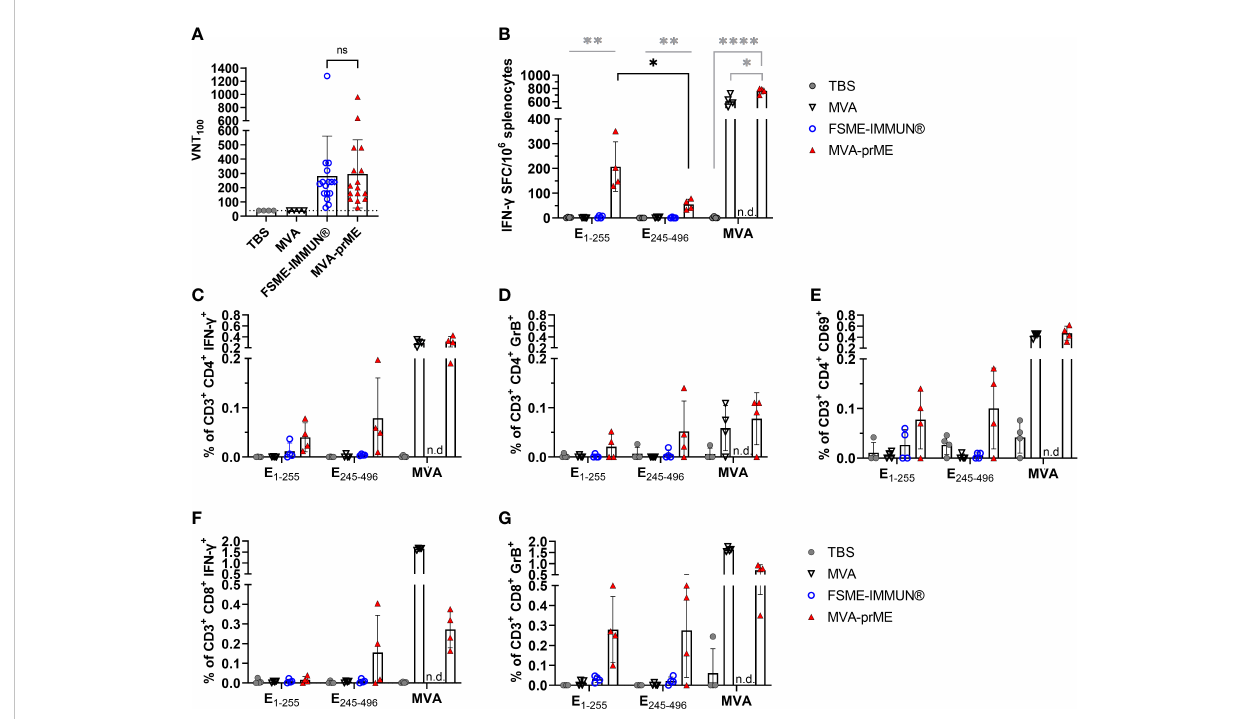
FIGURE 2 Humoral and cellular immune response in vaccinated mice. (A) Virus-neutralizing titer (VNT 100 ) against TBEV Neudoer fl of murine sera samples obtained 56 days after prime immunization (samples of immunogenicity and protective ef fi cacy study, n = 16). Samples with ≤ 40 VNT 100 (dotted line, lowest serum dilution) are considered negative. The FSME-IMMUN ® -vaccinated mouse that displayed signs of disease is highlighted with a diamond symbol. n.s., not signi fi cant ( p >0.05). (B) Displayed are IFN- g spot-forming cells (SFC) per one million splenocytes after background subtraction. Only signi fi cance between MVA-prME to other treatment groups is indicated (gray) and for E 1-255 versus E 245-496 of MVA-prME- vaccinated mice (black) (* p ≤ 0.05, ** p ≤ 0.01, **** p ≤ 0.0001). (C – G) Frequency of CD3 + subpopulations gated on CD4 + IFN- g + (C) , CD4 + Granzyme B + (D) , CD4 + CD69 + (E) , CD8 + IFN- g + (F) , or CD8 + Granzyme B + (G) after background substraction. n.d., not determined. For all graphs, bars show the mean with standard deviation. Mice were either immunized with TBS (gray circle), MVA (non- fi lled triangle), FSME-IMMUN ® (non- fi lled blue circle), or MVA-prME (red